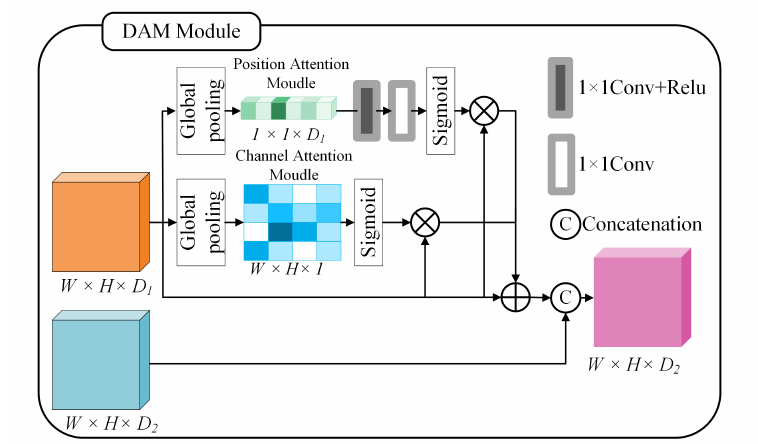
Figure 3. The dual attention module. The attention mechanism is adopted to adaptively aggregate different features, where the weights are normalized with the softmax function.